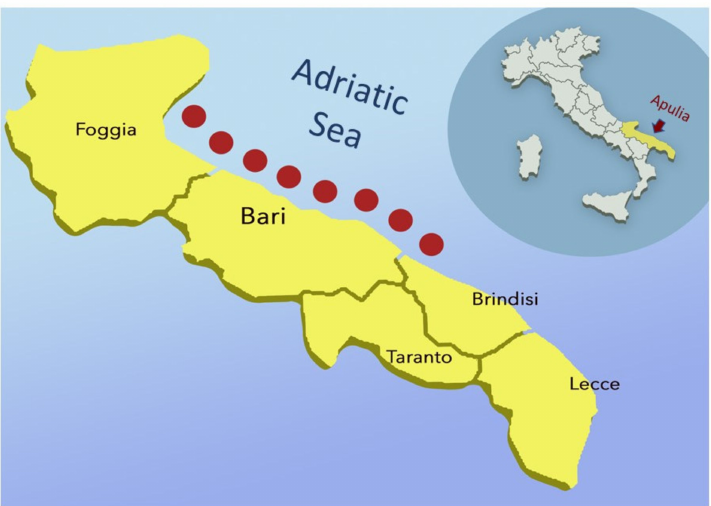
Figure 1. Map of sites (red dots) of the western Adriatic Sea near Apulia (yellow) where the loggerhead sea turtles were found stranded or captured by local fishermen. Image source: www. freepik.com (Accessed date 15 December 2020).